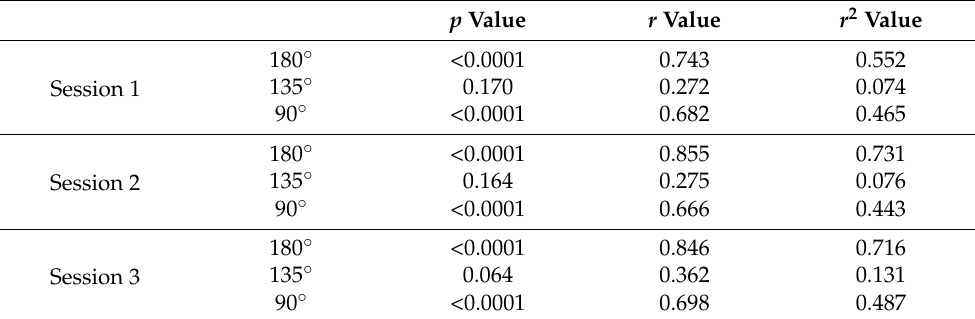
Table 12. Correlation between ASH test results using Active5™ and K-Force plates in the dominant upper limb in the male group. Correlation between ASH Test Results Using Active5™ and K-Force Plates in the Dominant